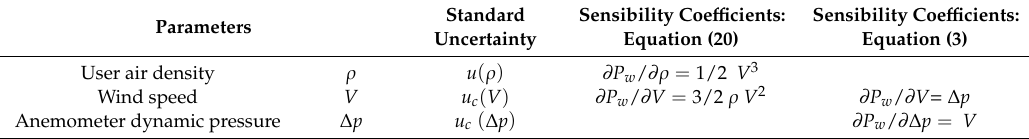
Table 2. Standard uncertainty and sensibility coe ffi cient of the wind power density equations.